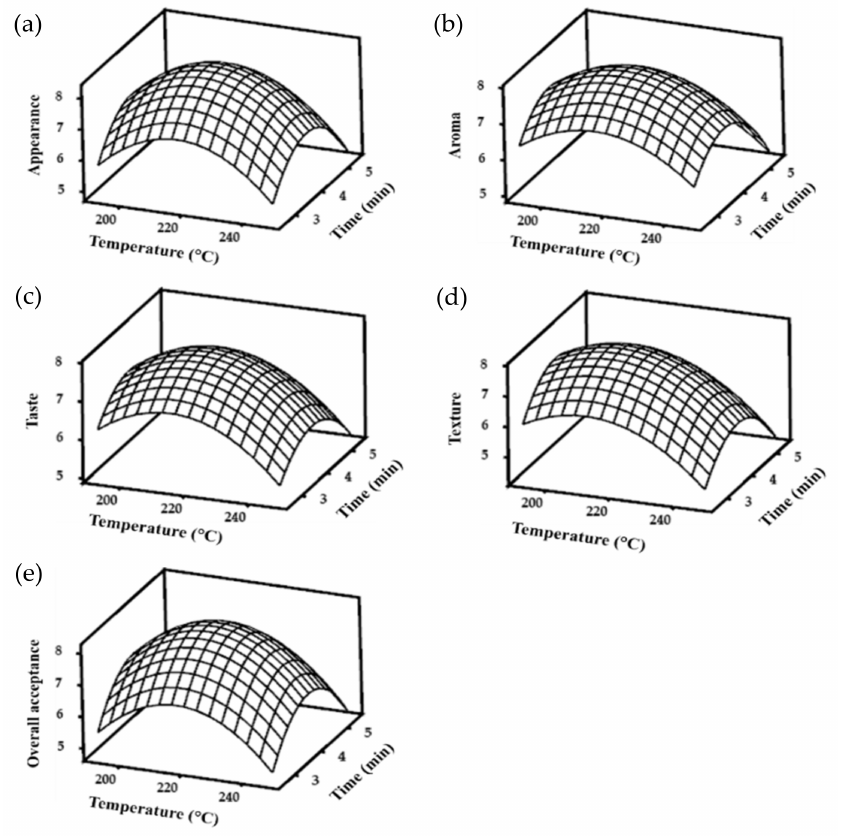
Figure 3. The response wireframe graph for ( a ) appearance, ( b ) aroma, ( c ) taste, ( d ) texture, and ( e ) overall acceptance of roasted Alaska pollack roe at the designated temperature and